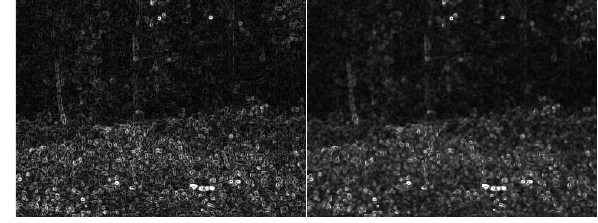
Figure 3. Noise suppression